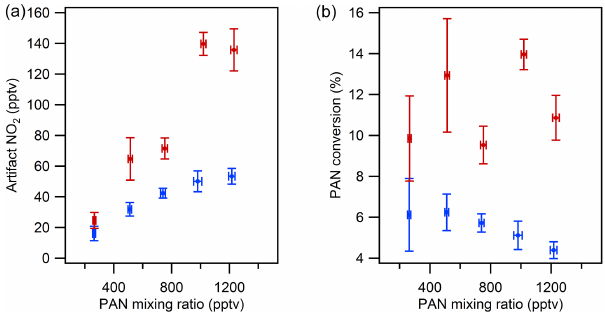
Figure 4. The measured NO 2 artifact signal as a function of the sup- plied PAN mixing ratio (a) , and as a percentage (b) , for the cooled (blue) and uncooled (red) high-powered